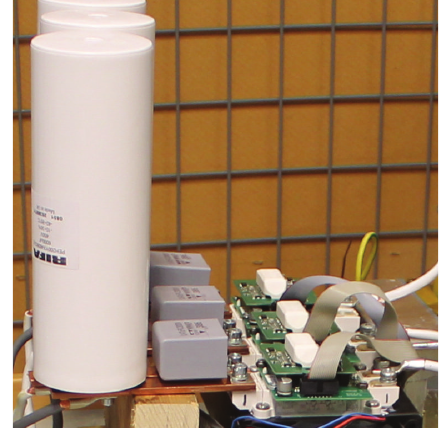
Figure 5: IGBT based voltage source inverter used in the experi- mental setup and the DC bank capacitors.